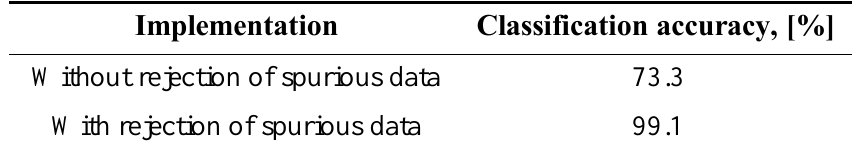
Table 7. Performance in the presence of spurious data (one spurious frame every three data